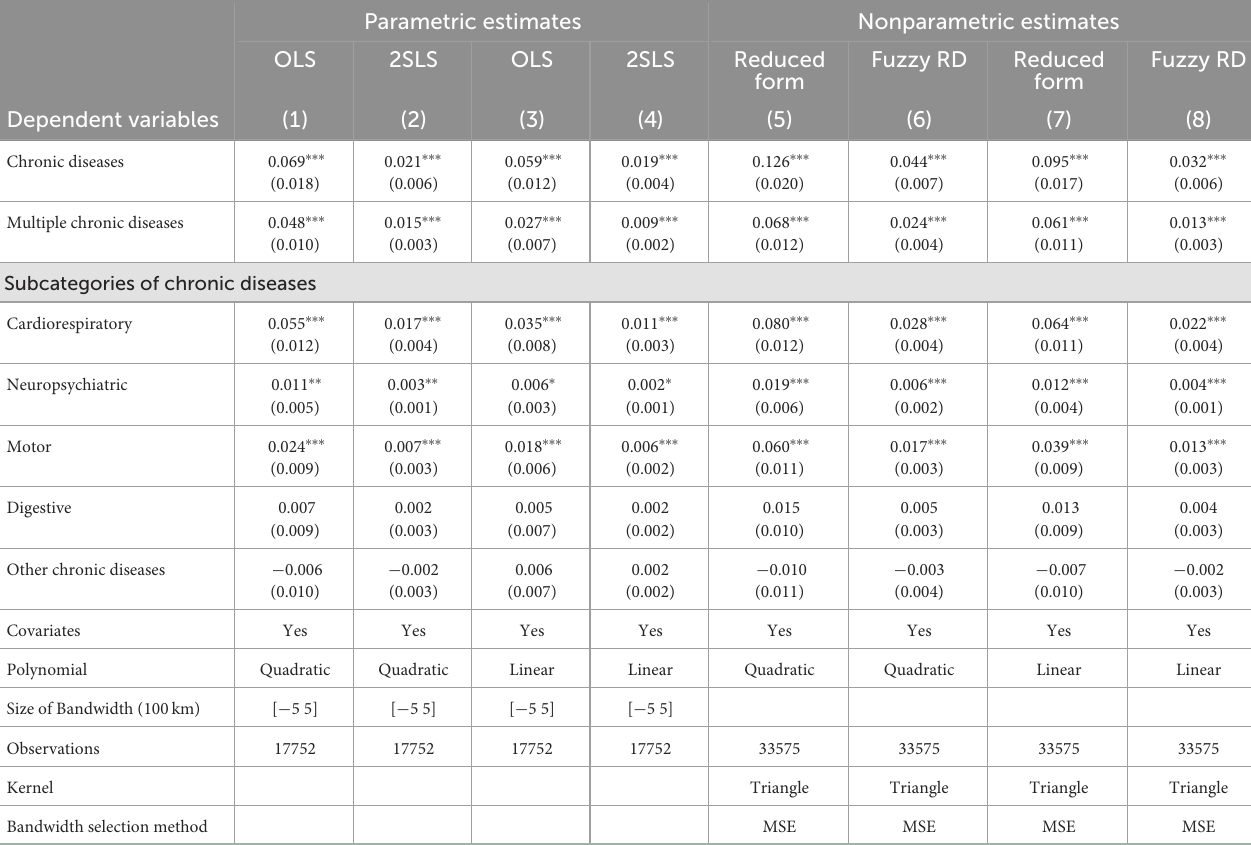
TABLE 3 RD estimates of the effect of the Huai River policy and 10 µ g/m 3 of PM 2.5 on health